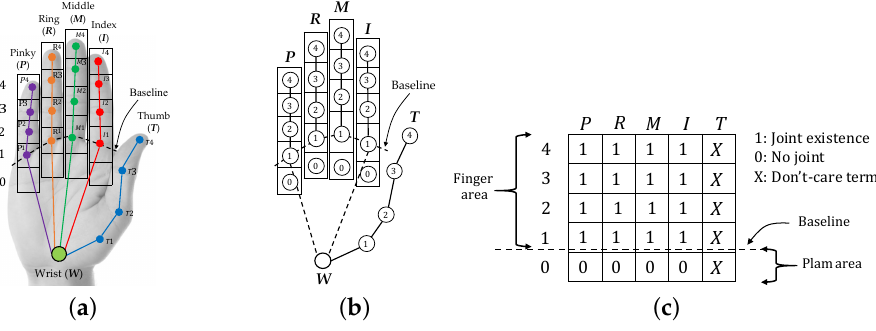
Figure 5. Definition of hand and template: ( a ) Finger joints and skeleton, ( b ) Template, and ( c )